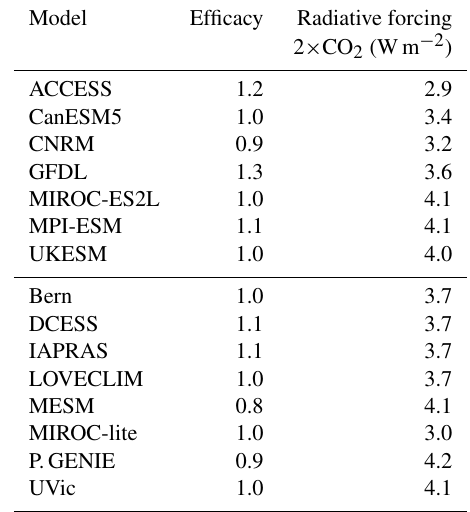
Table 4. Efficacy (cid:15) and radiative forcing for 2 × CO 2 R values for each model. Efficacy values are calculated from the 1pctCO2 exper-